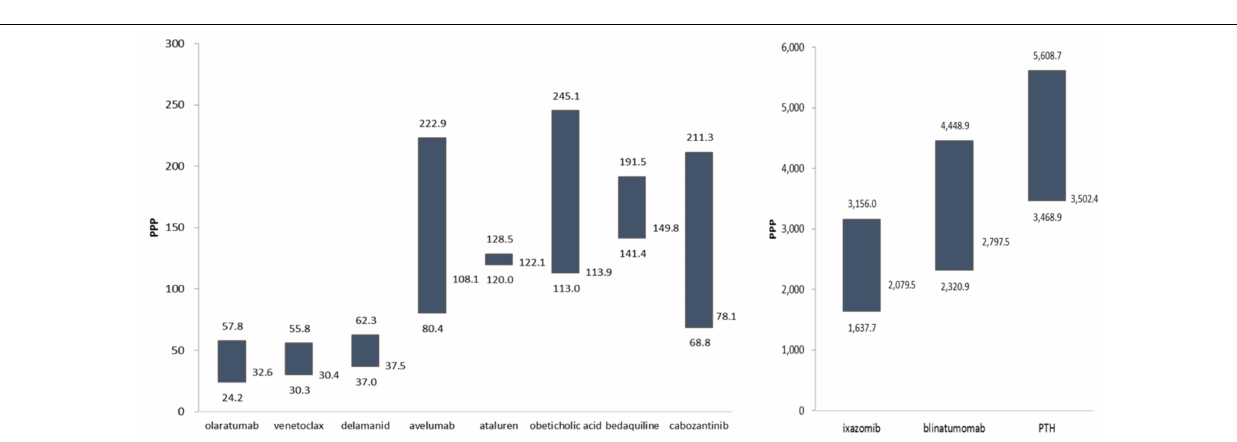
FIGURE 4 | Prices of the medicines with a conditional approval (PPP_USD, Maximum, Median, Minimum values). Holoclar was not depicted as German price was unidentified. Its price of 120,396 (PPP) in Italy was not